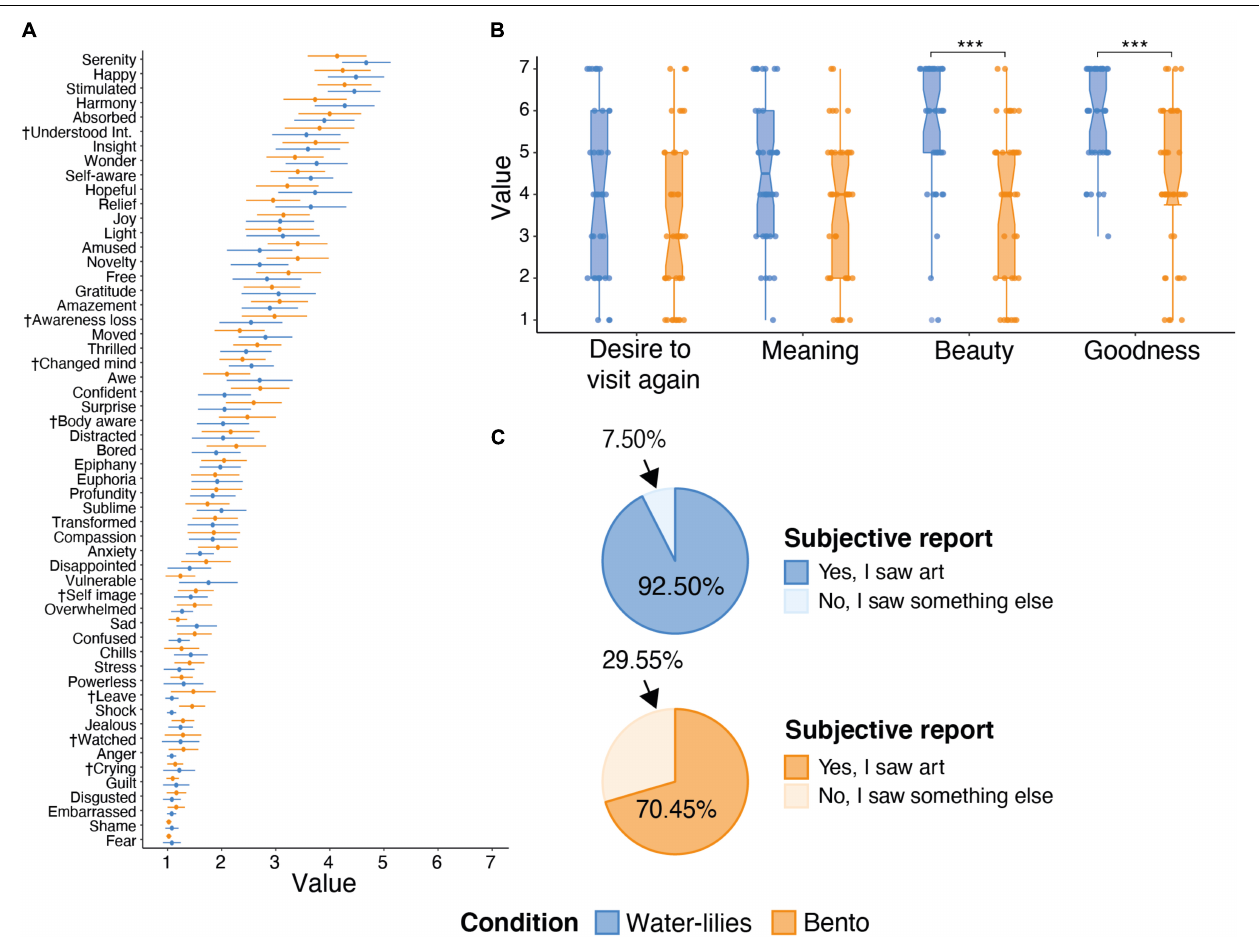
FIGURE 2 | (A) Shows means and 95% CI intervals for participants ratings of cognitive-emotional states during the online cultural engagements for the Water-lilies (light blue) and Bento (light orange) conditions. † shorthand labels, see Supplementary Material for the complete labels. (B) Box plots showing the ratings for aesthetic evaluation for the Water-lilies and Bento conditions, showing that in general Water-lilies condition was rated more highly. (C) Pie chart showing percentages of participants who reported to see art or something else while engaging online with the Water-lilies and Bento